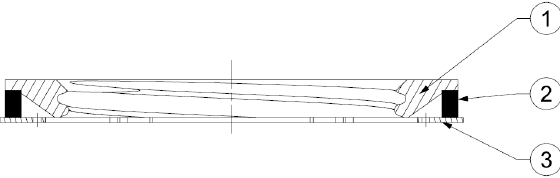
Figure 4. Damping unit with labeled components - connection element (1), damping element (2), steel plate